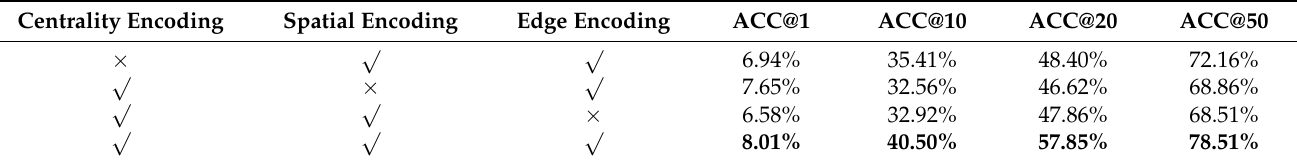
Figure 3. The accuracy of several models on the Weibo–Douban dataset. Table 5. Ablation experiment results on the Facebook–Twitter dataset.